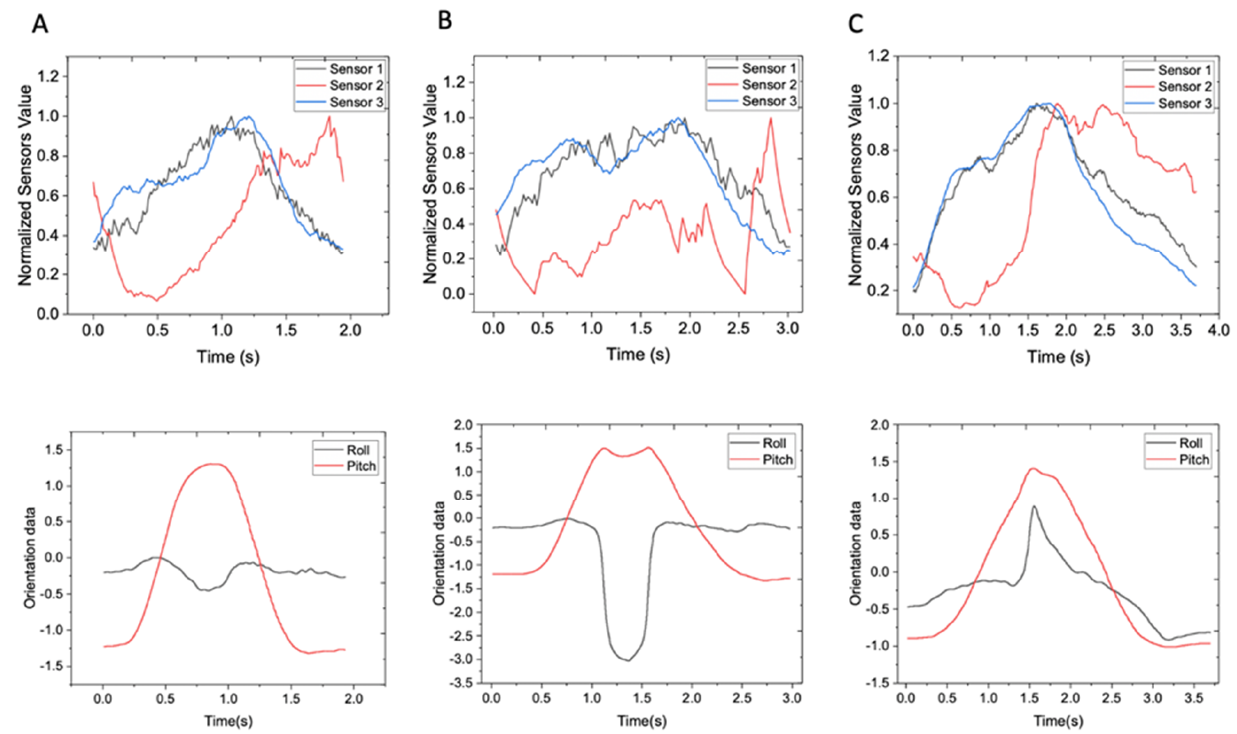
Figure 7. An example of one repetition of three force sensors with their corresponding pitch and roll angles during the second data collection step: ( A ) Force sensor and orientation signals for 2 Ib weight, ( B ) Force sensor and orientation signals for 5 Ib weight, ( C ) Force sensor and orientation signals for 8 Ib weight.